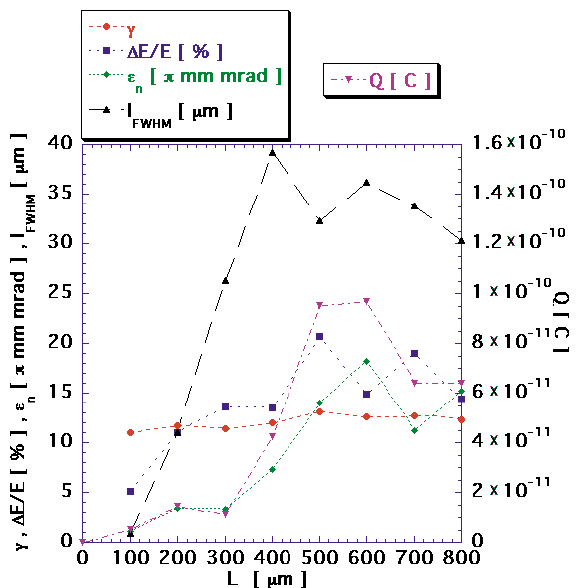
FIG. 4. (Color) Important beam characteristics as a function of the length of the density gradient on the side of the first gas jet where the laser exits it. The beam energy g , the energy spread D E (cid:3) E , the normalized emittance e n , the beam length l FWHM , and the beam charge Q are shown. Only electrons with p 1 $ 10 mc were included in the calculation of the numbers shown in the